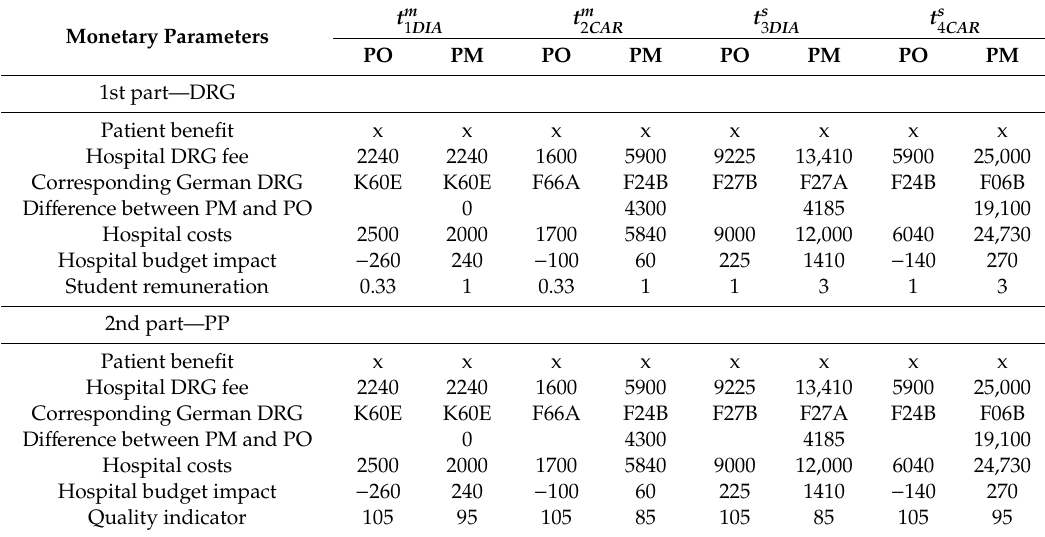
Table A3. Monetary Parameters for Medical Students w / o Patient Benefit—Treatment Cases